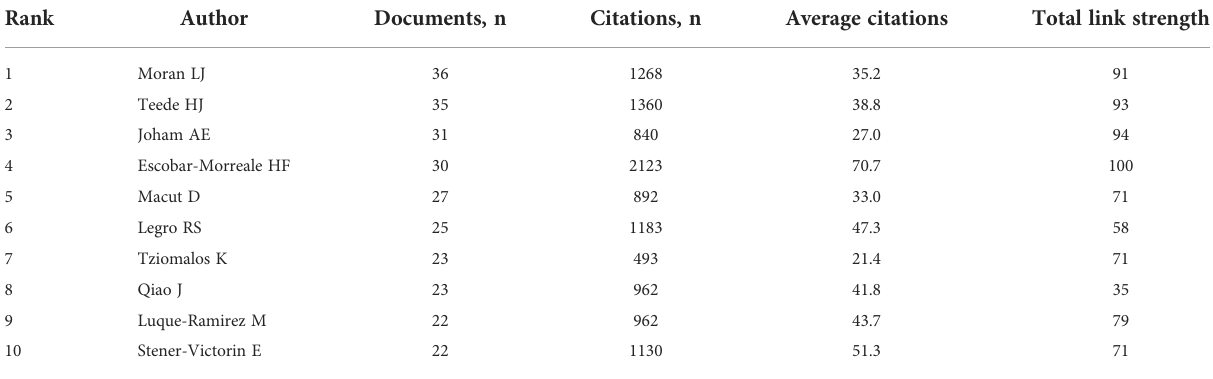
TABLE 2 Analysis of top 10 productive authors.